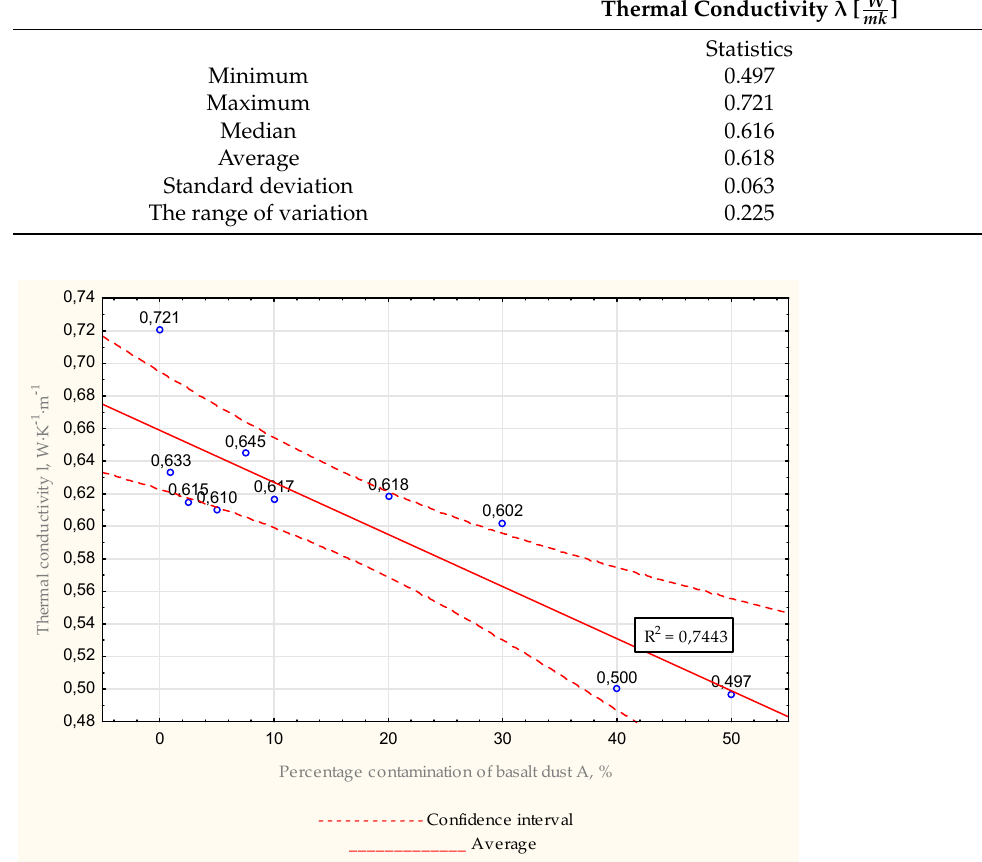
Figure 10. Average thermal conductivity for basalt dust A for water − mix ratio = 0.6.